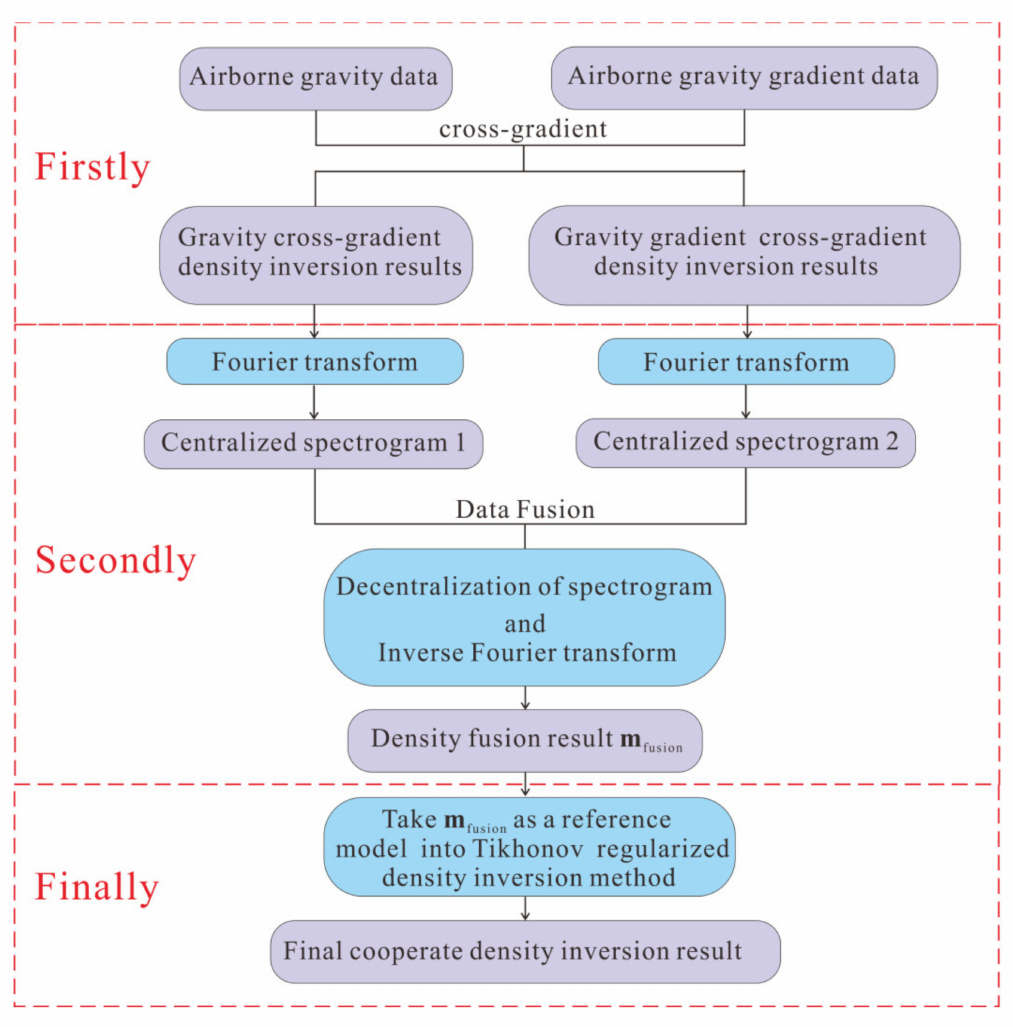
Figure 1. Flowchart of the cooperate density-integrated inversion